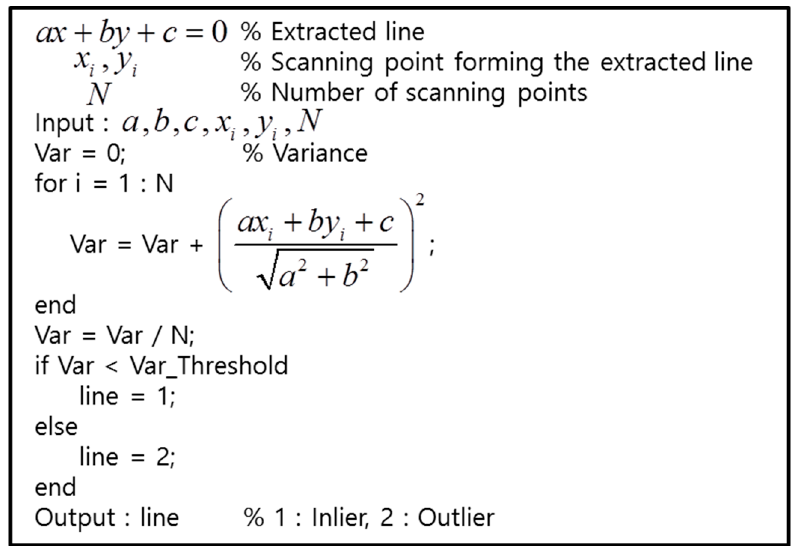
Figure 5. Pseudo code for outlier removal.